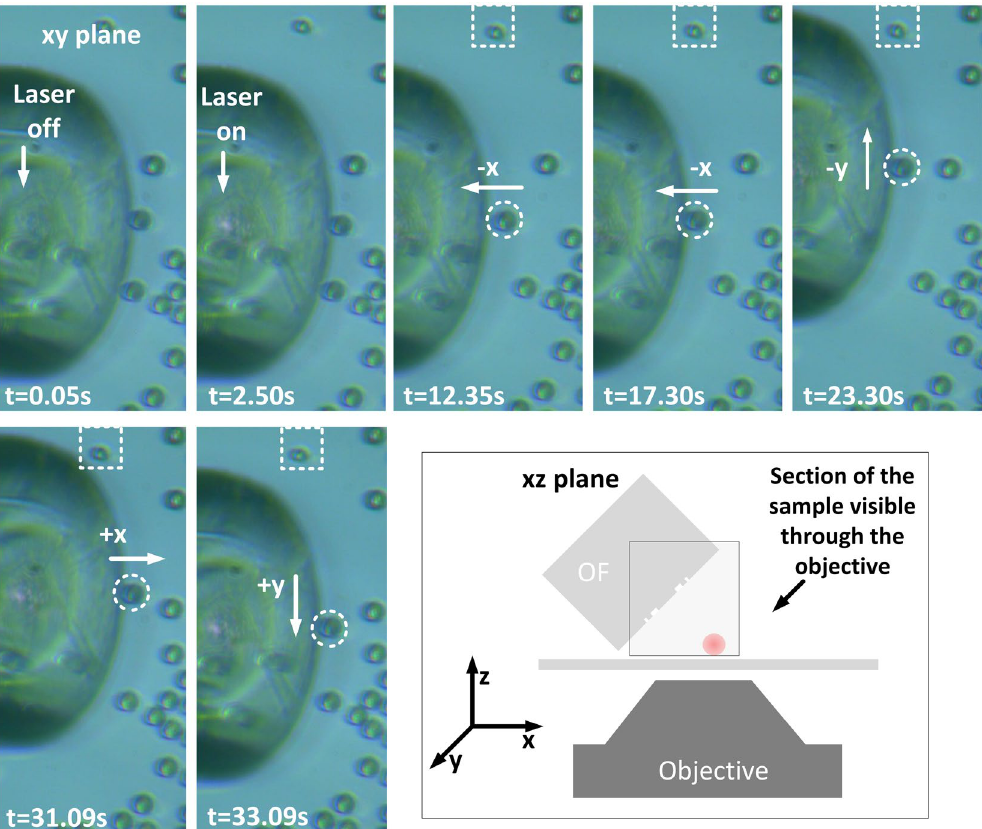
Figure 9. Demonstration of optical trapping of a PMMA particle in the xy plane. Scheme depicting the observer view, to demonstrate that the optical fibre does not touch the trapped particle (see Supplementary Video